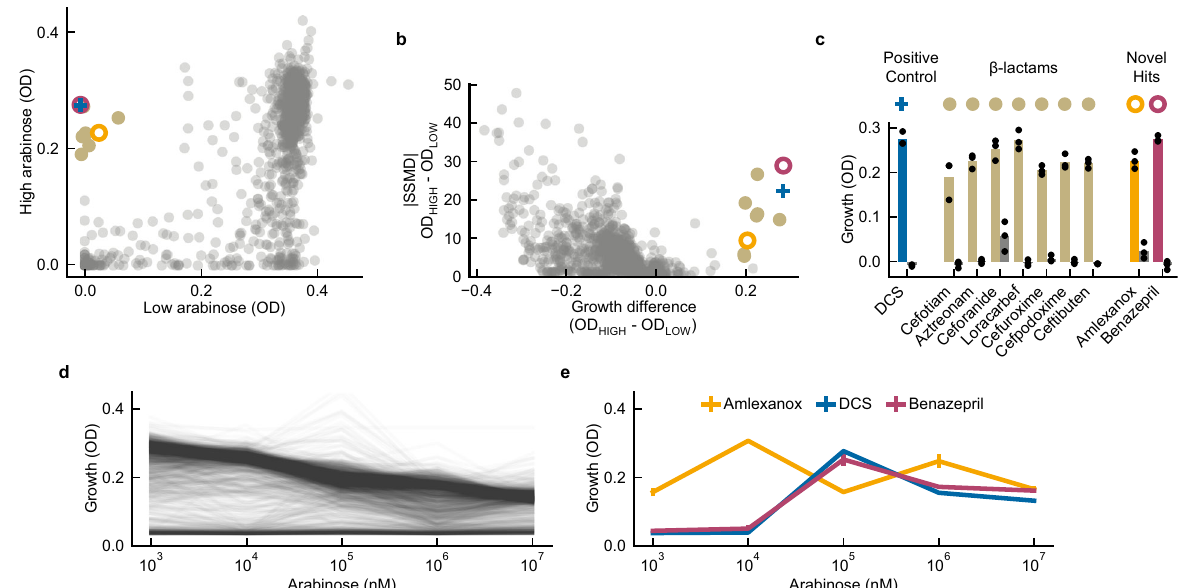
Fig. 2 A screen for targeted Mtb Alr inhibitors identi fi es benazepril. a The TESEC Mtb Alr expression strain was induced with arabinose at high (10 7 nM) or low (10 2 nM) levels and treated with the 1280-compound Prestwick library at 0.1 mM. Growth was measured by OD after 8 h and the median of three biological replicates is plotted for each drug. Hit compounds inhibit the growth of low-Alr strains but not high-Alr strains, occupying the upper-left quadrant. b SSMD scores were used to assess the statistical signi fi cance of the high- and low-induction growth levels. Hits were selected with an OD differential of 0.2 and an SSMD greater than 5. c Growth measurements for selected hits in high Alr (colored bars) and low Alr (gray bars) expression. Data are presented as the mean and individual data points for three biological replicates. d Chemical-genetic growth pro fi les of the TESEC Mtb Alr expression strain treated with each drug of the Prestwick library at 0.1 mM and a range of arabinose induction levels. e Selected chemical-genetic growth pro fi les for candidate hit compounds. Both DCS and benazepril showed growth inhibition only at low induction levels. Amlexanox, in contrast, did not show reproducible induction-speci fi c activity. Data are presented as the mean and the standard deviation of three replicates. Source data are provided as a Source Data fi le.